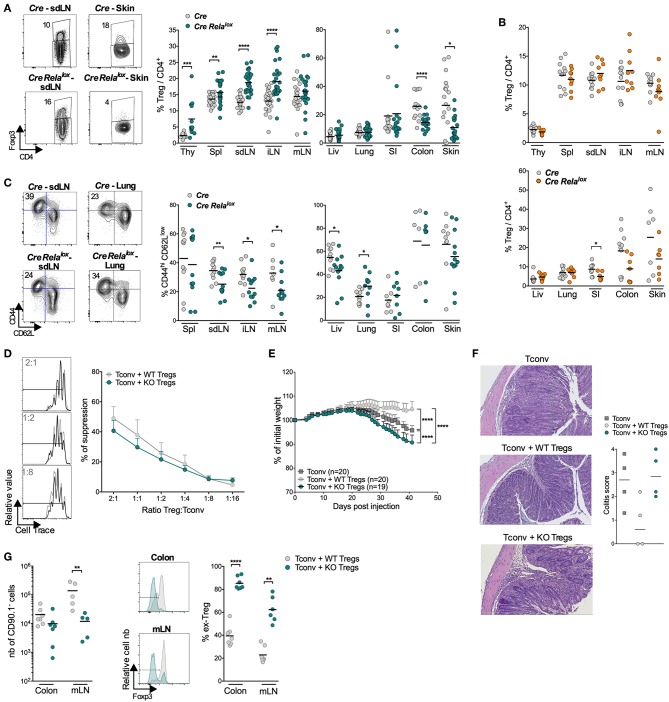
Tregs in Foxp3Cre
Relalox mice appear to be less stable. (A) Representative density plot and proportion of Tregs among the CD4+ T cells in the indicated organs (thy, thymus; spl, spleen; liv, liver; SI, small intestine) of 12 week-old Foxp3Cre (Cre) and Foxp3Cre
Relalox (Cre Relalox) mice. (B) Proportion of Tregs among CD4+ cells in 5 week-old Foxp3Cre and Foxp3Cre
Relalox mice. (C) Representative density plots and proportions of CD44hi CD62Llow among the Tregs of 12 week-old Foxp3Cre and Foxp3Cre
Relalox mice. Each dot represents a mouse and lines show the means of pooled independent experiments. (D)
In vitro suppressive activity of Treg cells from Foxp3Cre (WT Tregs) and Foxp3Cre
Relalox (KO Tregs) 5–6 week-old mice. Representative data at 2:1, 1:2 and 1:8 (left) and different (right) Treg:Tconv ratios of independent experiments. (E–G)
In vivo suppressive activity of Treg cells from Foxp3Cre (WT Tregs, 6 week-old mice) and Foxp3Cre
Relalox (KO Tregs, 6 week-old mice) mice, determined in a colitis model stopped at 6 weeks for analyses. (E) Percentage of initial body weight pooled from independent experiments. Error bars represent SEM. (F) Representative histology of the colon and colitis scores. (G) Numbers of recovered Tregs (CD90.1− cells), representative histograms and proportions of ex-Treg in the mLN and colon. Each dot represents a mouse and lines show the means of pooled independent experiments. For mouse and experiment numbers, see Supplementary Table 1. The two-tailed unpaired non-parametric Mann–Whitney U test was used for data not following a normal distribution and the t-test was used for data following a normal distribution. *p < 0.05, **p < 0.01, ***p < 0.001, ****p < 0.0001.